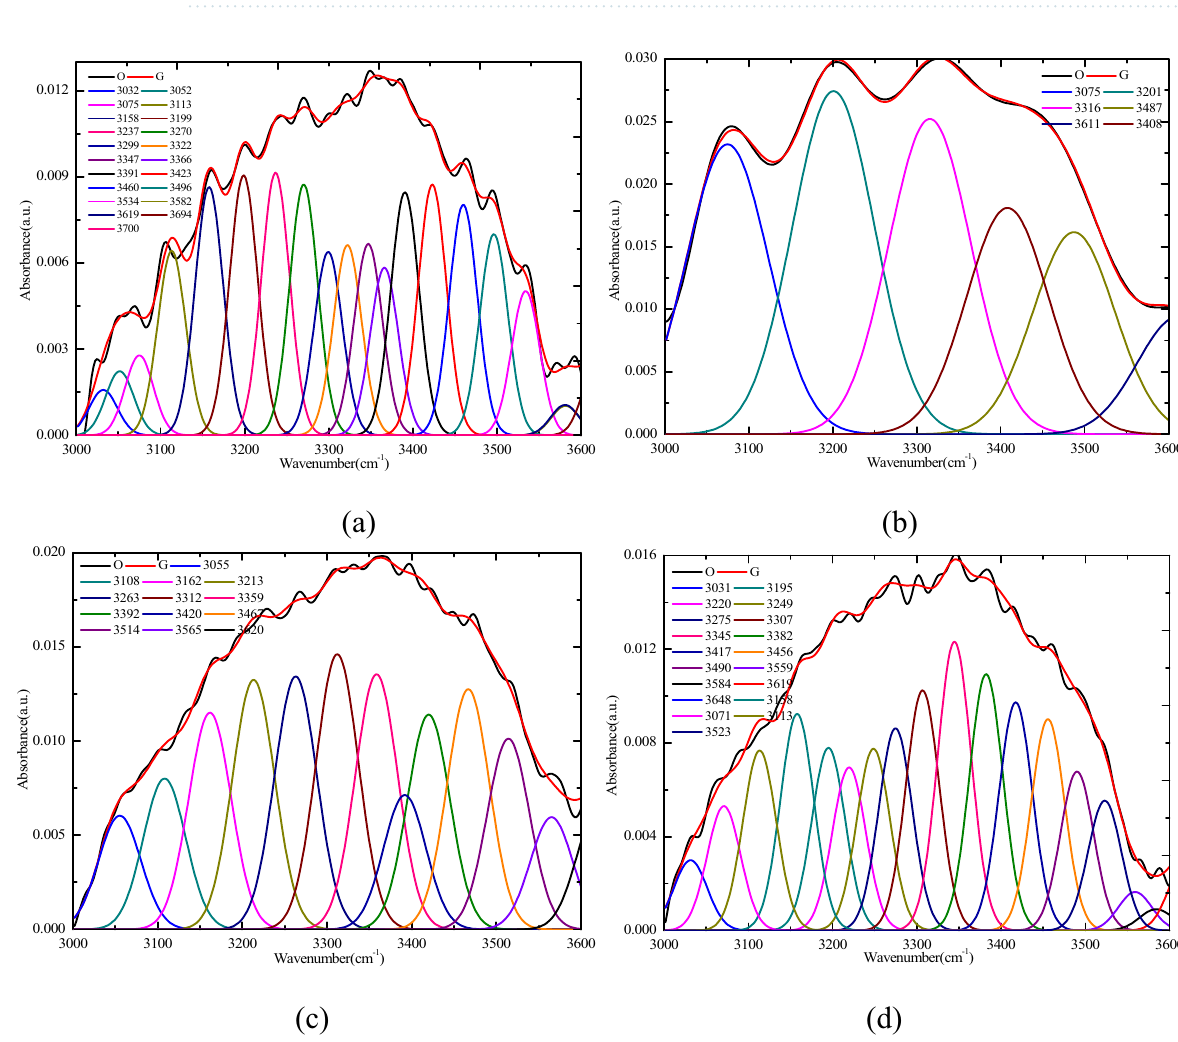
Figure 7. Fitted curve of FTIR spectrum ranging from 3000 to 3600 cm −1 . ( a ) R C , ( b ) Sad-8 h, ( c ) Sad-24 h, ( d ) Sad-48